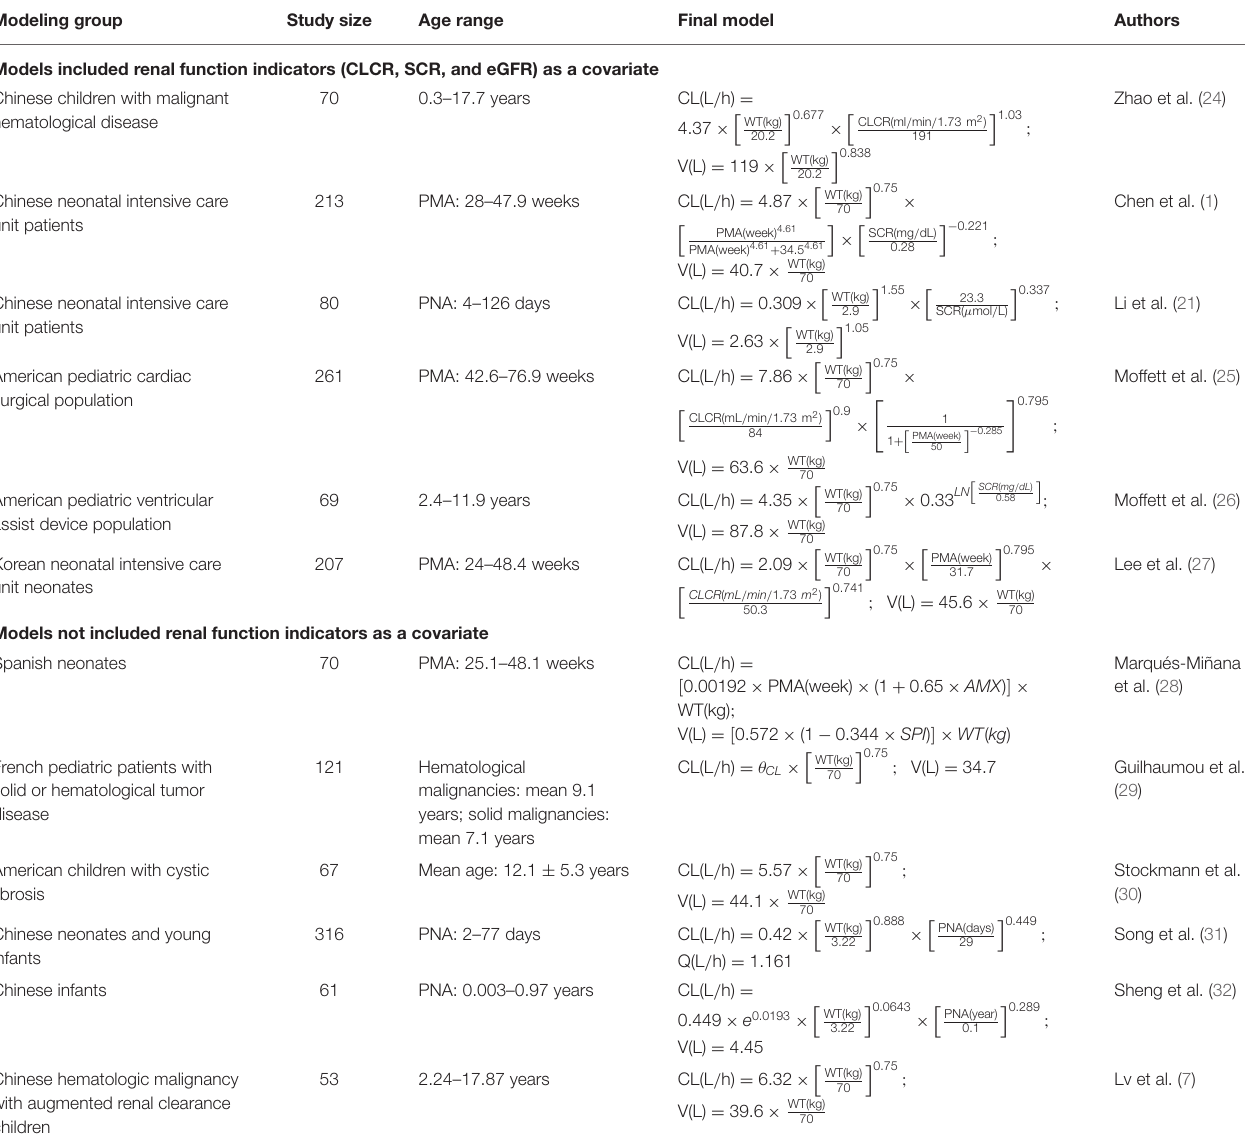
TABLE 1 | A mini-review of previous vancomycin PPK models for pediatric patients. Modeling group Study size Age range Final